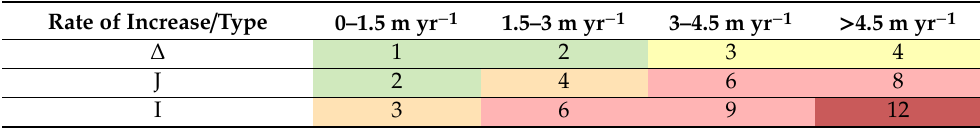
Table 4. Spatial interpolation algorithm has been used in order to produce the landslide hazard map (Figure 14). Table 4. Weight of the landslide hazard in the study area. Green color represents the low hazard, yellow and light orange represent moderate hazard and red and dark red color high